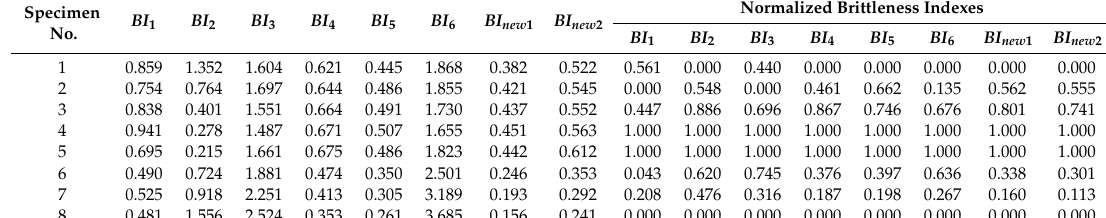
Table 3. Brittleness indexes of glutenite specimens.